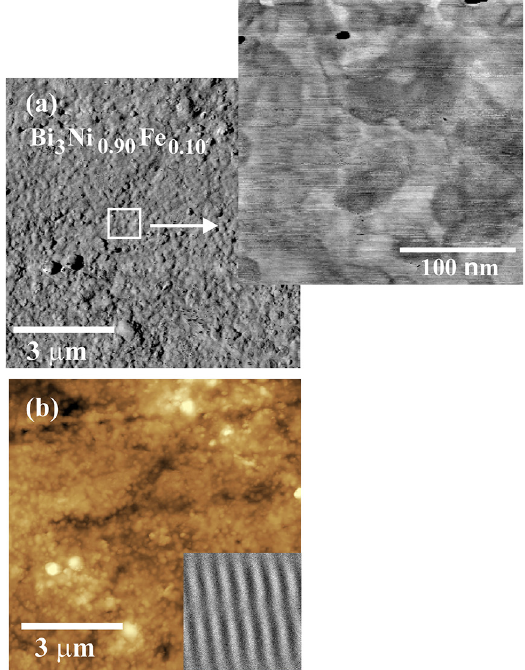
Ni Fe 3 0.90 0.10